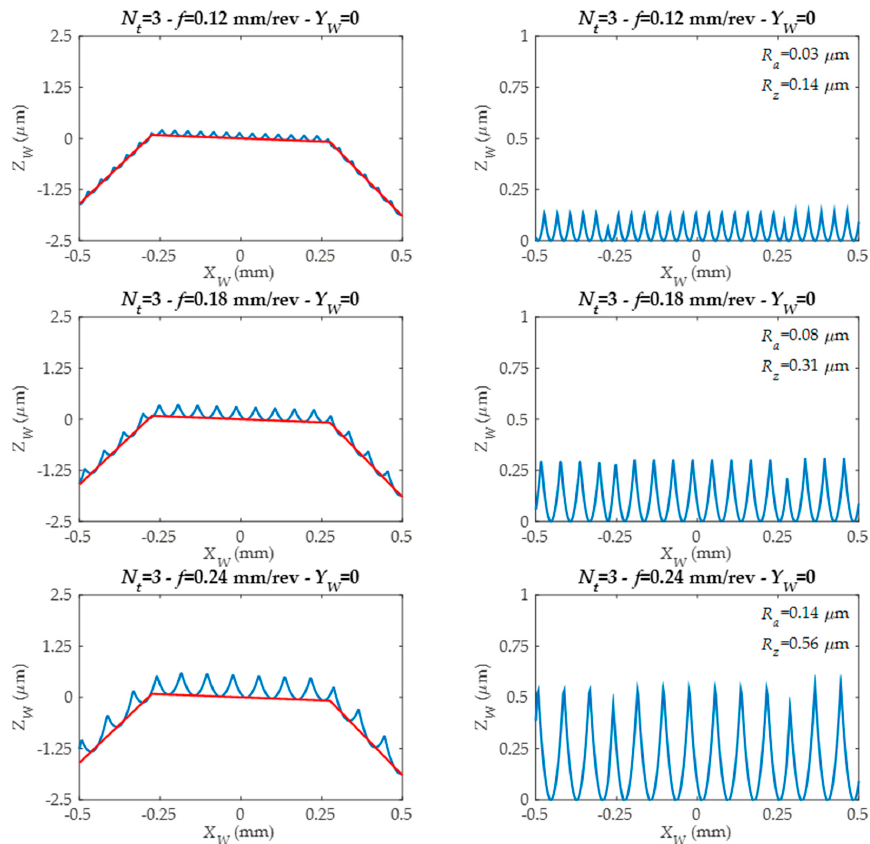
Figure 13. Predicted roughness profiles for tools with different edge numbers and working with different feed values.